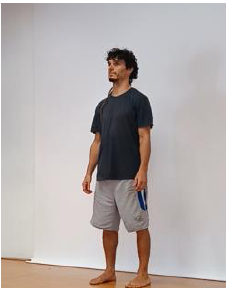
Figure 9. One of the actors, right before recording a movement